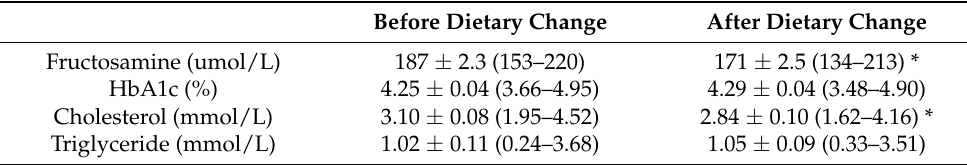
Table 3. Descriptive statistics on biochemical parameters related to glycemic response and lipid metabolism before and after dietary change. n = 44. Mean ± SE (minimum–maximum) are reported. * p < 0.05.